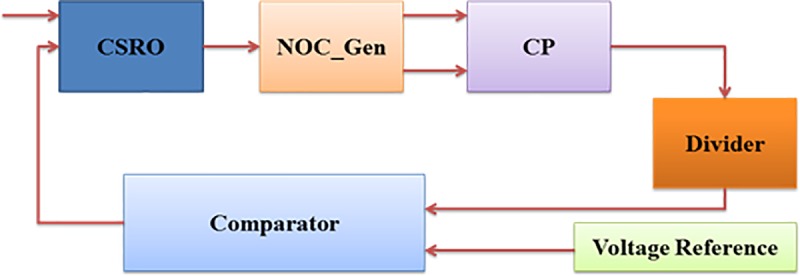
Block diagram of the proposed HVG.